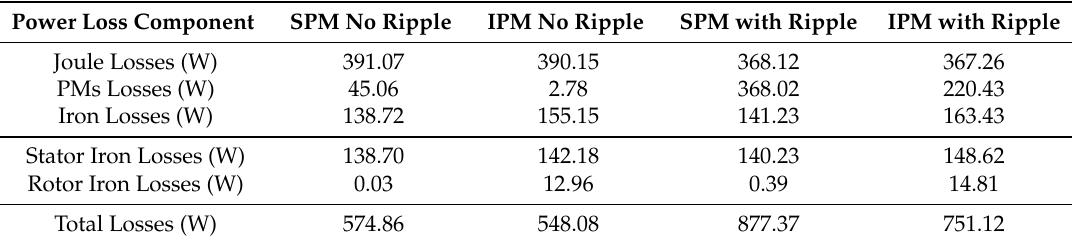
Table 2. Power losses of reference SPM and proposed IPM